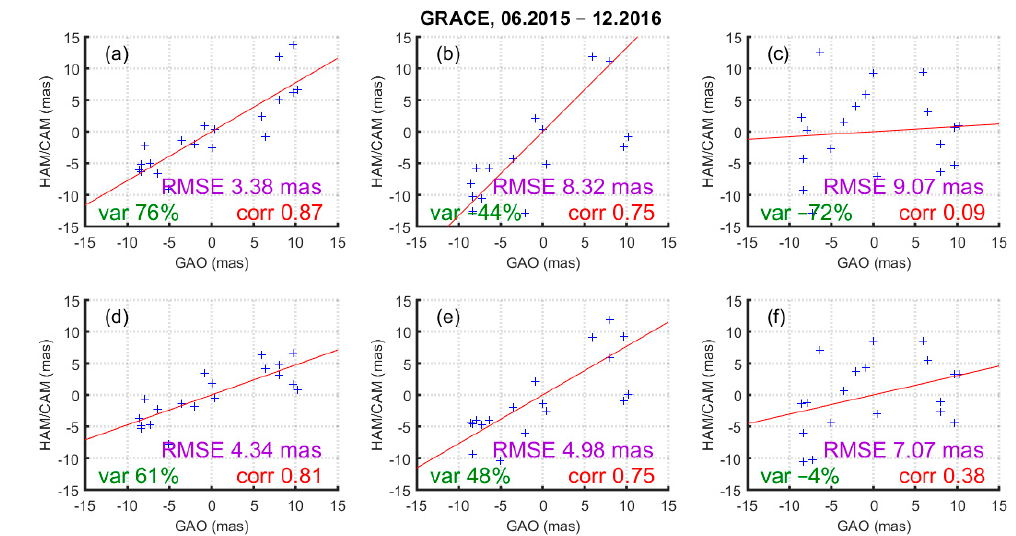
Figure 11. Scatter plots showing the relationship between the χ 2 component of GAO and HAM/CAM from ( a ) CSR GSM, ( b ) JPL GSM, ( c ) GFZ GSM, ( d ) CSR TWS, ( e ) JPL TWS, and ( f ) GFZ TWS. The red line was fitted to the data points using the least squares method. The values in purple indicate the RMSE, the values in red (corr) indicate the correlation coefficients between series, and the values in green (var) indicate the relative explained variances. The considered time period is June 2015 to December 2016. Note that the critical value of correlation coefficient for 12 independent points and a 95% confidence level is 0.50, while the standard error of the difference between two correlation coefficients is 0.47. All the parameters were computed after removal of trends.